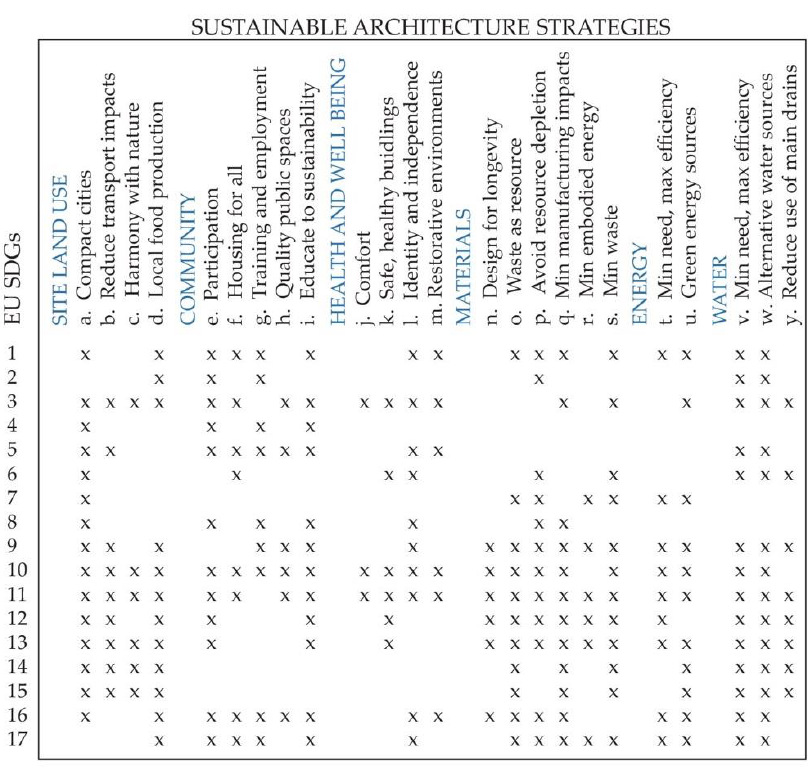
Figure 1. Potential impact of Sustainable Architecture Strategies (SAS) [14] on the Sustainable Development Goals (SDGs) [19].